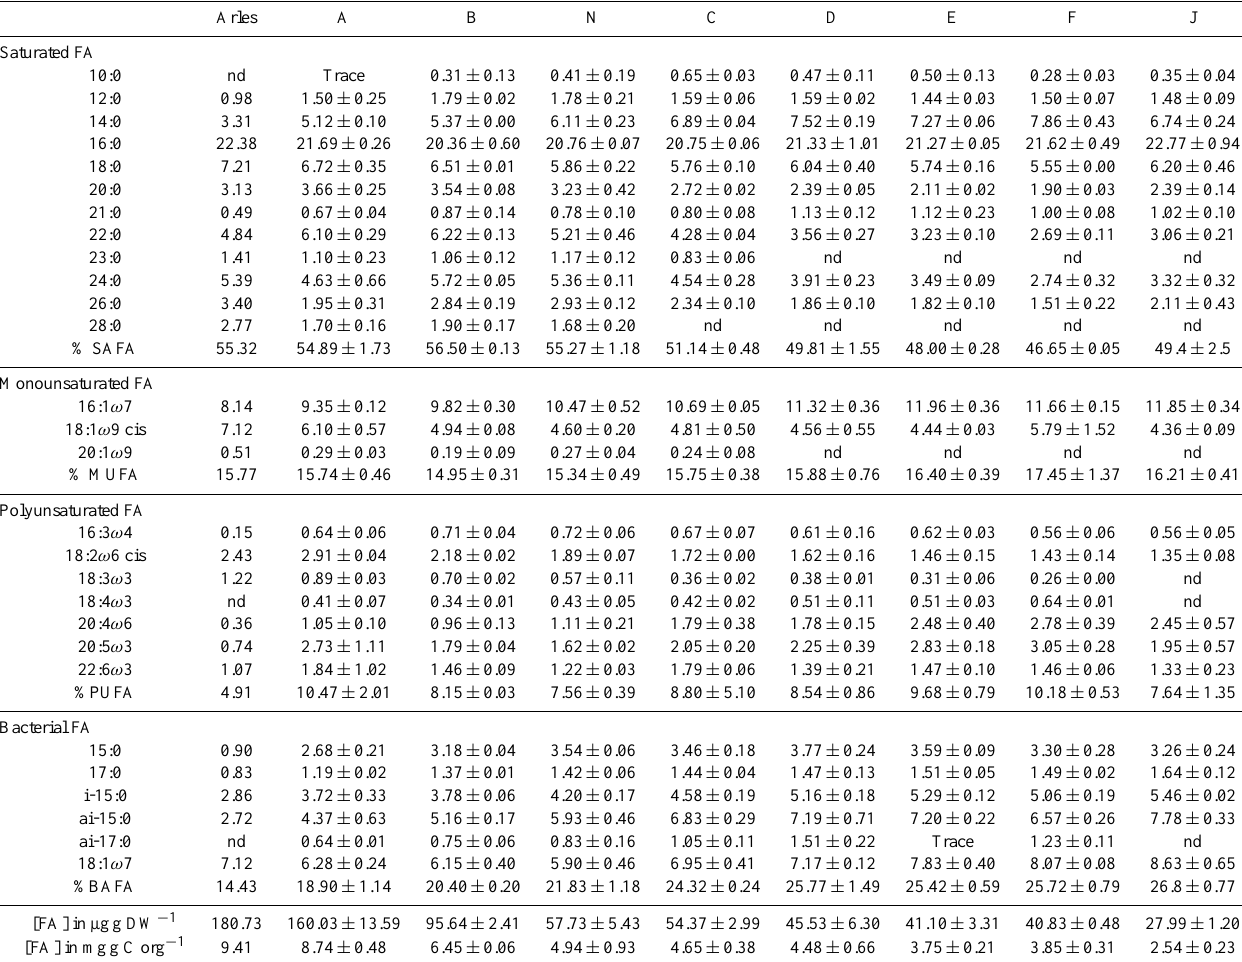
Arles A B N C D E